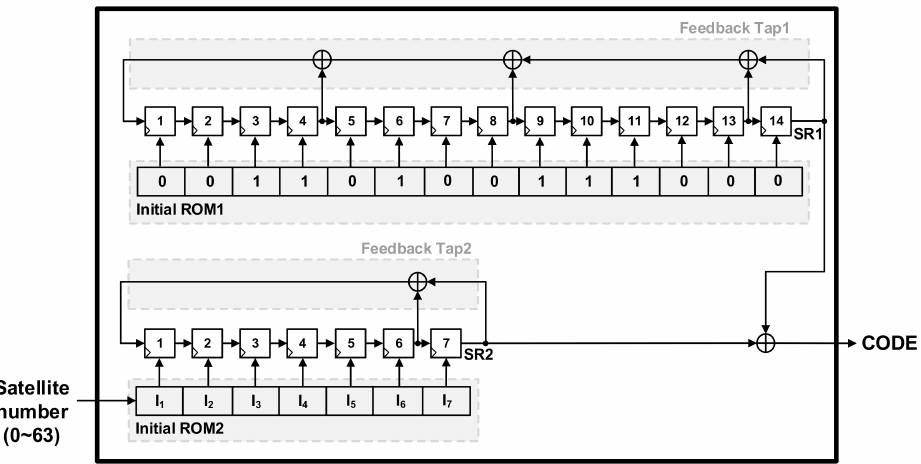
Figure 3. Conventional code generator architecture of GLONASS L2OC signal